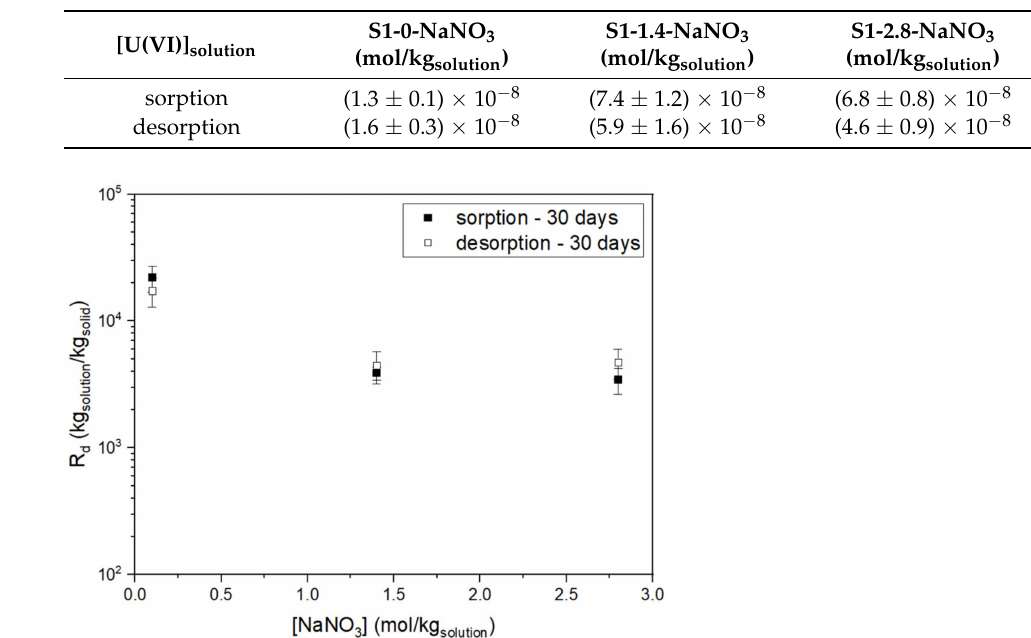
Table 4. U(VI) concentration measured by TRLFS in supernatant after 1 month of sorption or desorption as a function of NaNO 3 content.